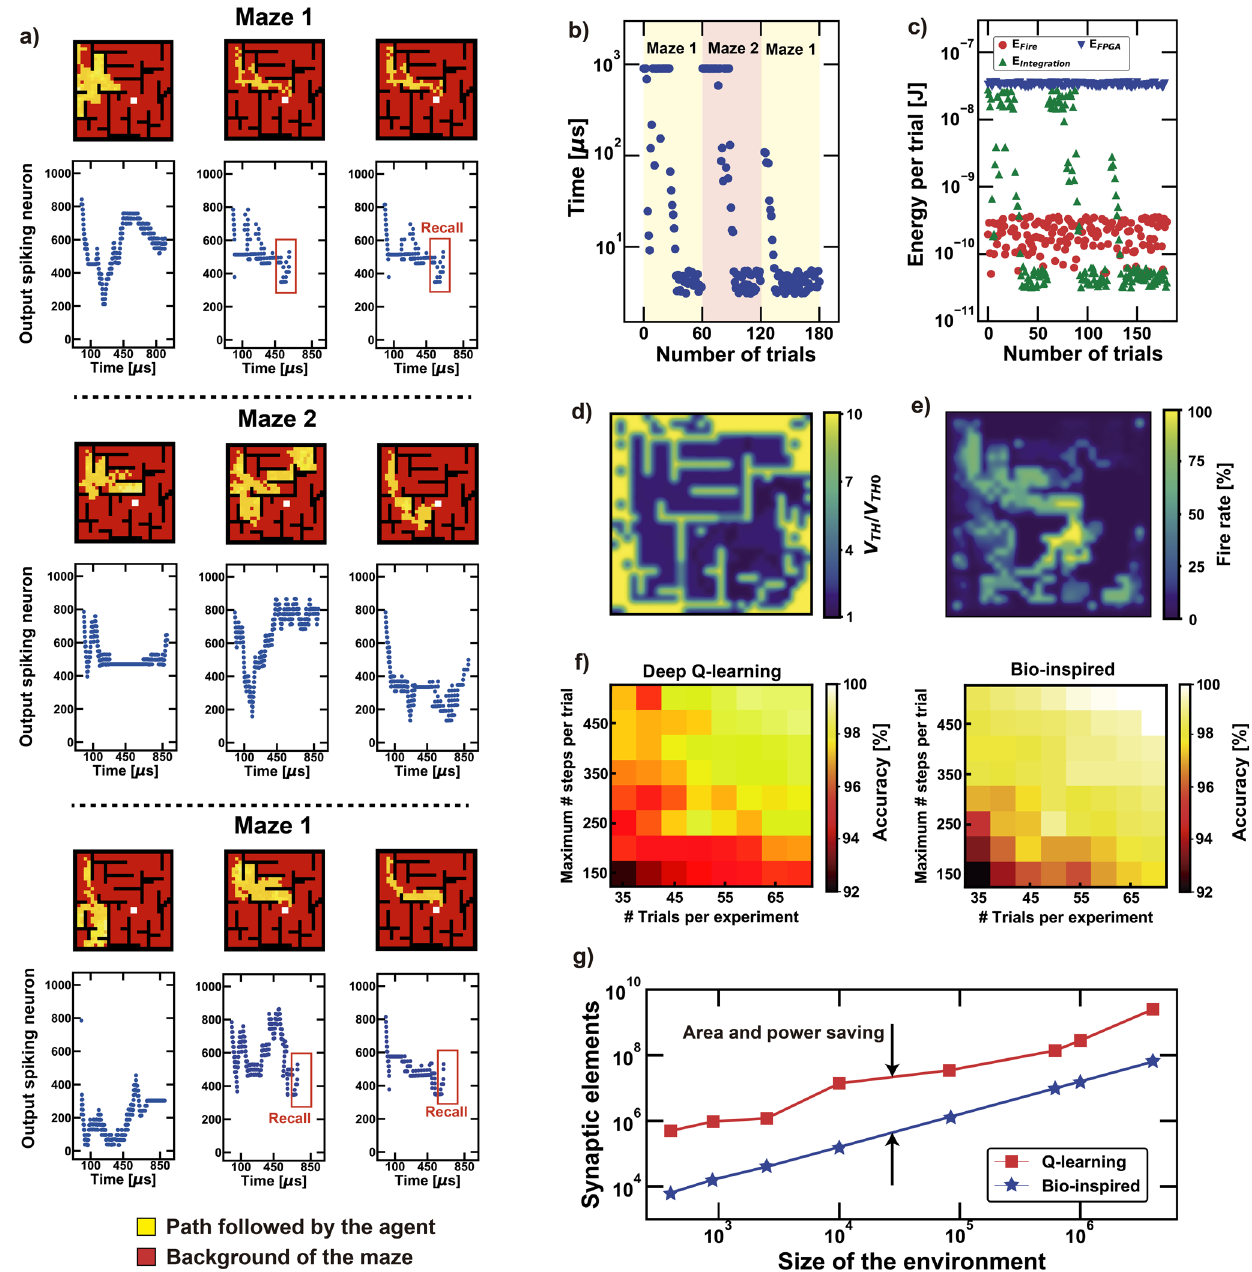
Fig. 4 | Recall property in dynamics environments and power ef fi ciency of the system. a Experimental results for 9 successive trials of a maze which changes topological con fi guration every 3 trials. The system explores the environment to fi nd the reward and it recalls the fi rst solution once the previous con fi guration is proposed. b The timetoget the solutionimproves fromtrialto trialalong withthe optimization of the policy. However, note that, once the maze changes shape, the reward time increases accordingly since a new solution must be found. When the maze comes back to the previous situation the fi rst solution is recalled. c Energy consumption tendency for each core of the system. d Once the initial point is changed from trialto trial,the energyconsumptionstays high, but a policymap of thewholeenvironmentisretrieved. e Mapofthe fi ringrateoftheneurons,showing